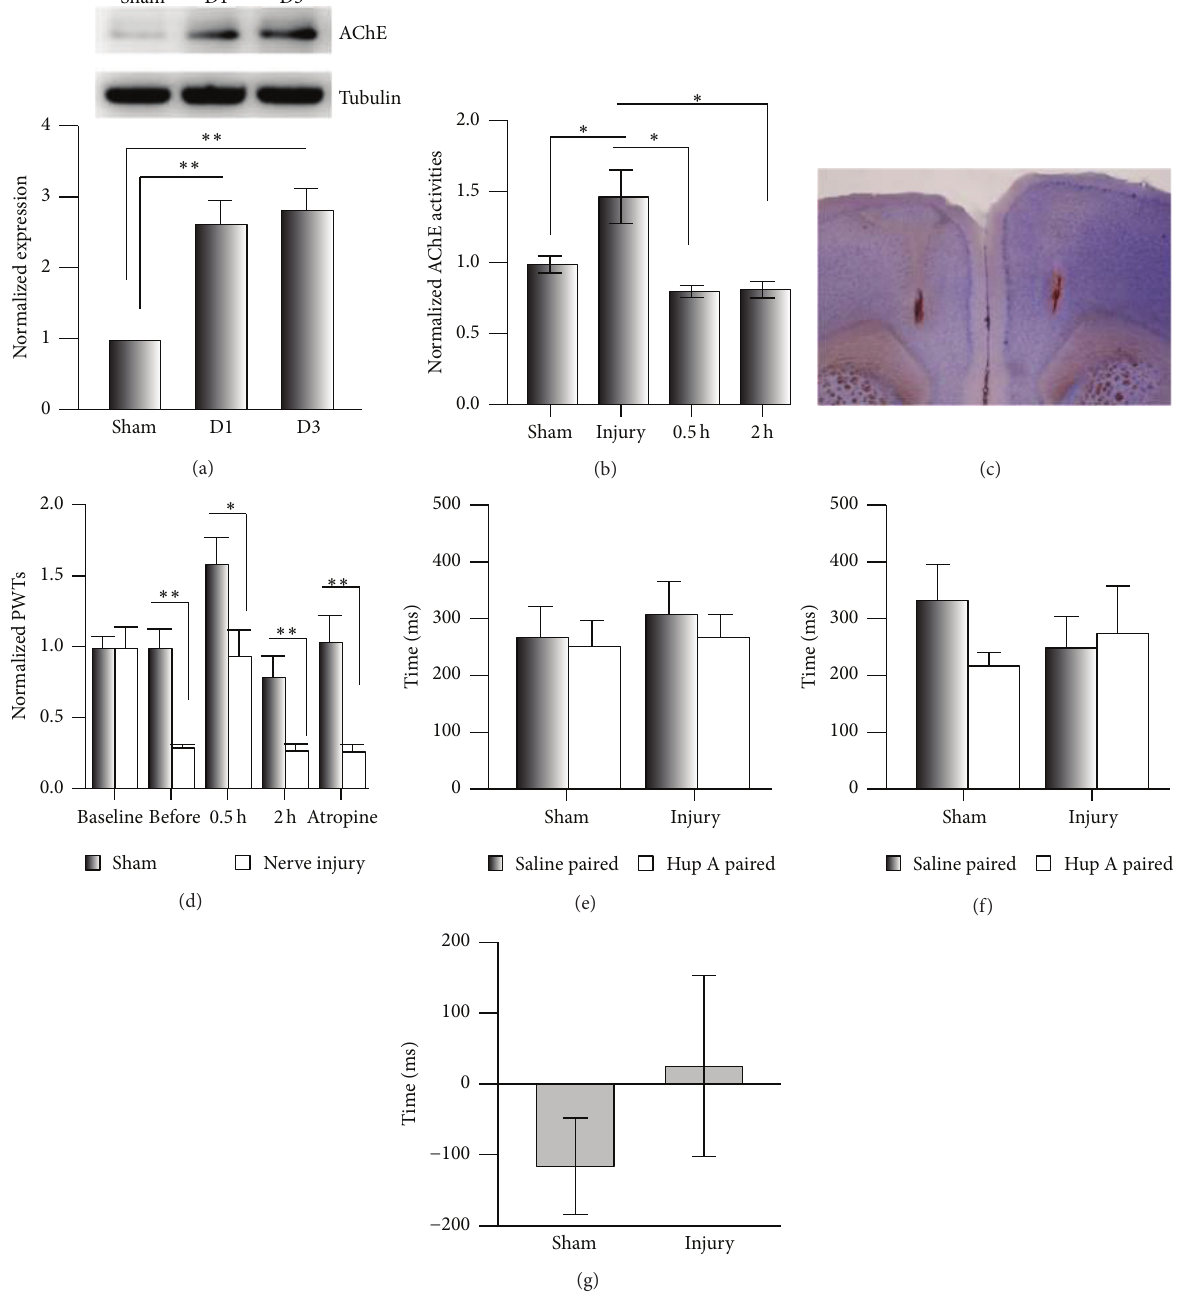
Figure 4: Infusion of Hup A into the anterior cingulate cortex did not alleviate spontaneous neuropathic pain. (a) The expression levels of AChE in the ACC were increased by the nerve injury (one-way ANOVA, 𝐹 2;14 = 14.64 , 𝑃 < 0.01 ; 𝑛 = 5 per group, ∗∗ 𝑃 < 0.05 under SNK test). (b) The AChE activity in the ACC of mice with nerve injury was increased, and this was inhibited by Hup A at 0.1mg/kg, i.p. (one-way ANOVA, 𝐹 3;26 = 5.81 , 𝑃 < 0.01 ; 𝑛 = 10 for sham group, 𝑛 = 9 for injury, 𝑛 = 4 for 0.5 h group and 2 h group, ∗ 𝑃 < 0.05 under SNK test). (c) An example showing the injection site in the ACC of hematoxylin and eosin stained brain section. (d) Infusion of Hup A into the ACC increased PWTs in the sham and nerve-injury groups, and atropine blocked this analgesic effect (two-way RM ANOVA, sham versus injury: = 14.89 , 𝑃 < 0.01 ; treatments: 𝐹 = 15.93 , 𝑃 < 0.01 , 𝑛 = 5 per group, ∗∗ 𝑃 < 0.01 under Tukey’s test). (e) Time spent in the chambers 𝐹 1;49 4;49 during the preconditioning period of the CPP test (two-way RM ANOVA, sham versus injury: 𝐹 1;15 = 0.39 , 𝑃 > 0.05 ; saline versus drug: = 0.27 , 𝑃 > 0.05 , 𝑛 = 4 per group). (f) Infusion of Hup A into the ACC did not induce a preference for the drug-paired chamber in the 𝐹 1;15 CPP test (two-way RM ANOVA, sham versus injury: 𝐹 1;15 = 0.09 , 𝑃 > 0.05 ; saline versus drug: 𝐹 1;15 = 0.40 , 𝑃 > 0.05 , 𝑛 = 4 per group). (g) No change occurred in the preference time induced by Hup A in the CPP ( t -test, 𝑃 > 0.05